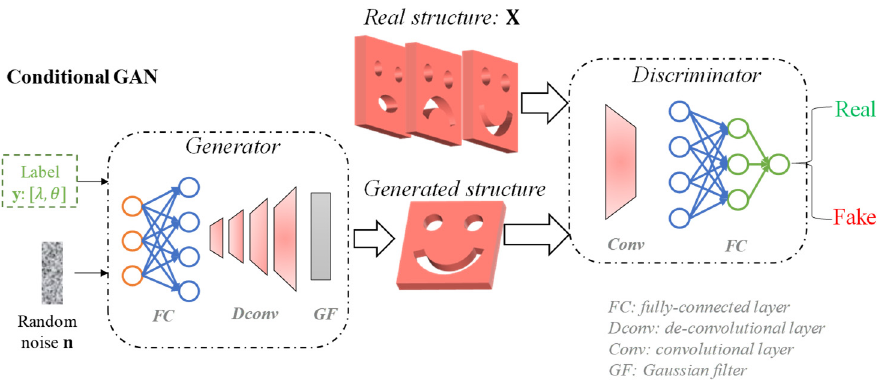
Figure 9. Training process of a CGAN to design irregular metagratings.